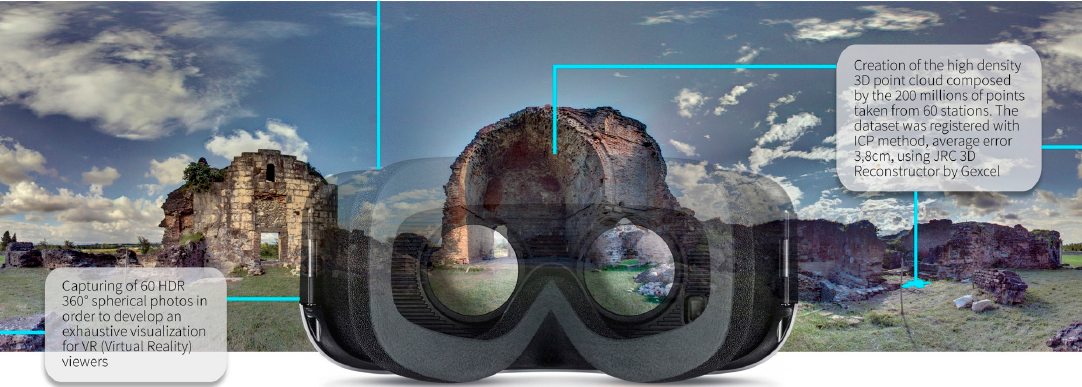
Figure 1. Virtual experience mock-up: by the use of a head-mounted display the Geguti Palace will be explored and information on the 3D survey will be